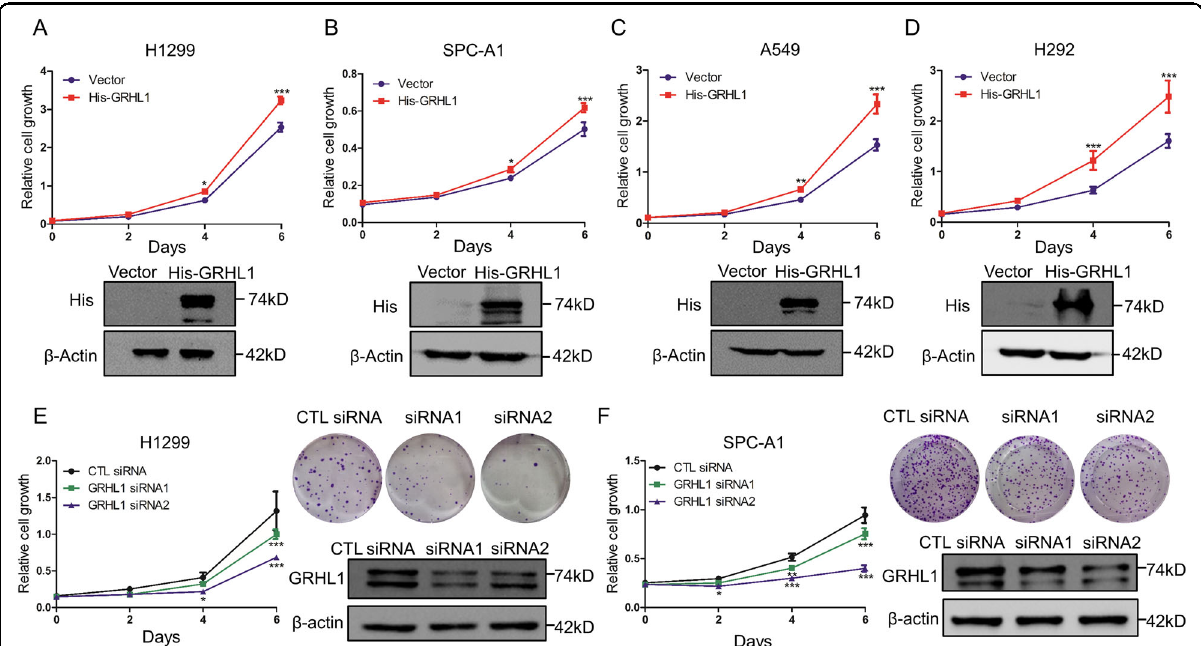
Fig. 2 GRHL1 promotes the proliferation of NSCLC cells. A – D H1299 ( A ) cells, SPC-A1 ( B ) cells, A549 ( C ) cells, and H292 ( D ) cells were transfected with pcDNA3.1 plasmid or pcDNA3.1-His-GRHL1 (His-GRHL1) plasmid. At the indicated times, cells were fi xed in 3.7% formaldehyde and stained with 0.1% crystal violet. Data represent the average of three independent experiments (mean ± SD). * P < 0.05, *** P < 0.001. Western blot was used to examine the expression of the indicated proteins. E, F H1299 ( E ) and SPC-A1 ( F ) cells were transfected with control (CTL) siRNAs or GRHL1 siRNAs. At the indicated times, cells were fi xed in 3.7% formaldehyde and stained with 0.1% crystal violet. Data represent the average of three independent experiments (mean ± SD). * P < 0.05, ** P < 0.01, *** P < 0.001. For colony formation assay, H1299 and SPC-A1 cells were transfected with control siRNA or siRNAs targeting GRHL1. Eight days later, colony formation was detected by crystal violet staining and photographed. Protein expression was assessed by western blot using indicated